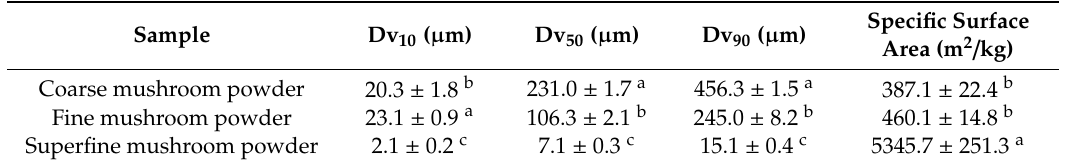
Table 3. Particle size and specific surface area of coarse, fine and superfine powders produced from white button mushrooms exposed to a 30-min UV-B